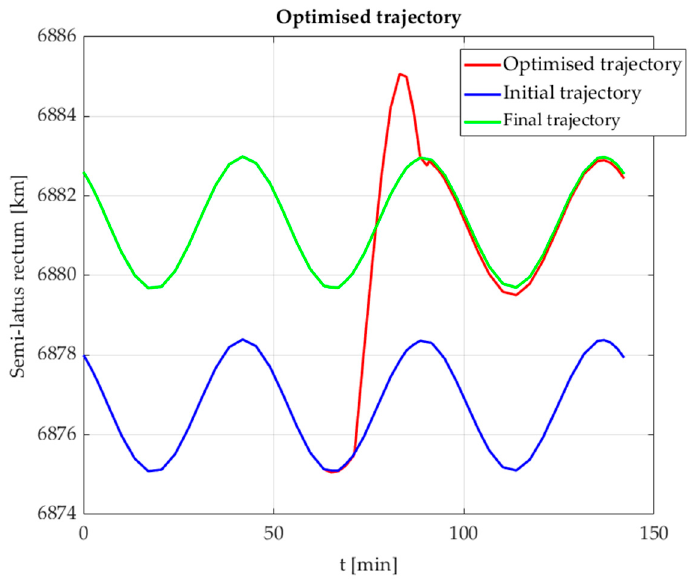
Figure 15. Change in semimajor axis from initial to final trajectory (SBSS).